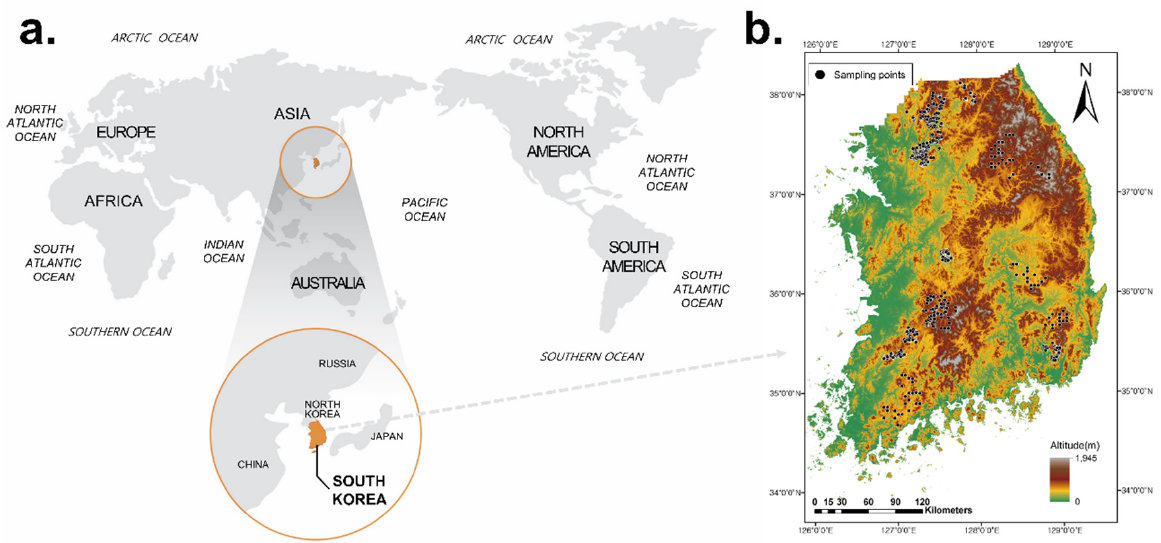
Figure 1. ( a ) South Korea’s global location and ( b ) its 953 forest soil sampling sites.